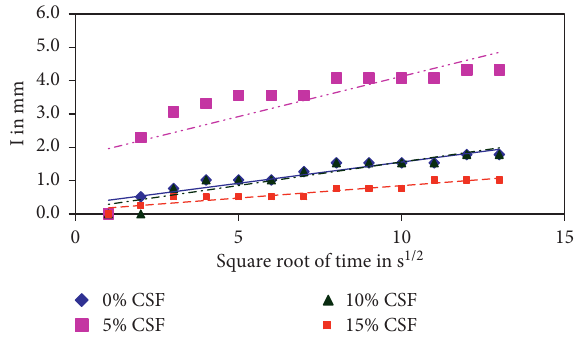
Figure 21: Sorption coefficient of CSF.